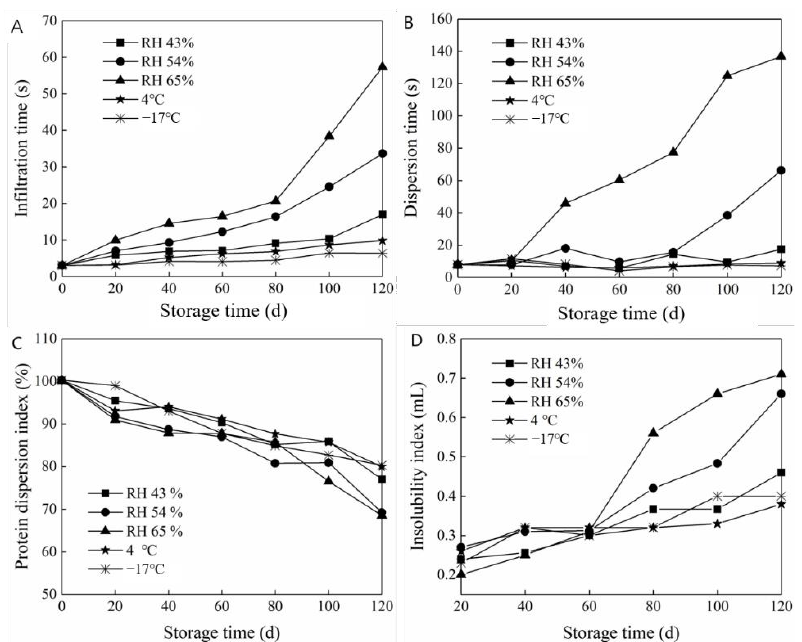
Figure 6. Quality change in prepared milk powder during packaging and storage. ( A ) the infiltration time, ( B ) the dispersion time, ( C ) the protein dispersion index and ( D ) the insolubility index.